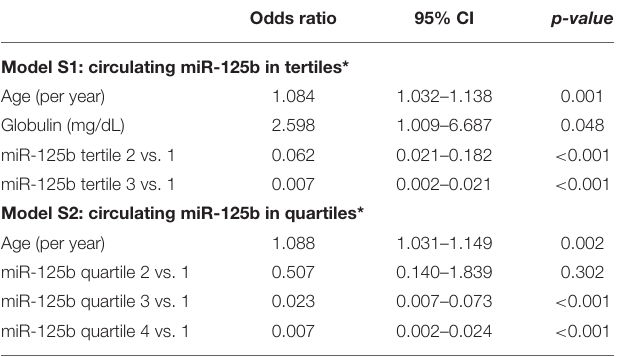
TABLE 3 | Sensitivity analyses. Odds ratio 95% CI